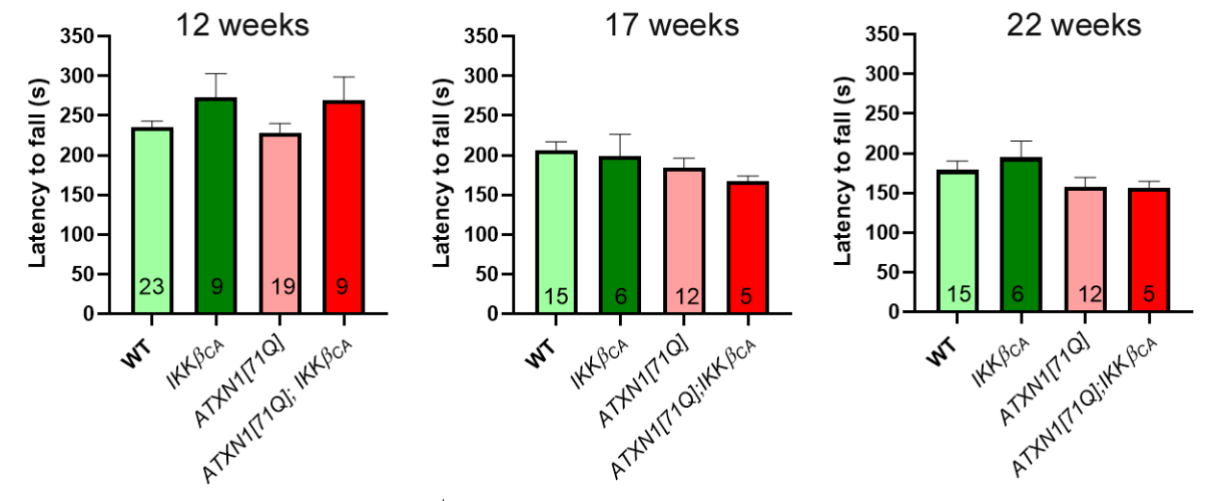
Figure 4. Rotarod performance of ATXN1[71Q] and ATXN1[71Q];IKK β CA mice is not impaired even at late stages of disease. Rotarod performance of mice at 12, 17, and 22 weeks. Error bars = S.E.M., using one-way ANOVA with Bonferroni’s multiple comparison test. Number of mice used for quantification is present in bars.